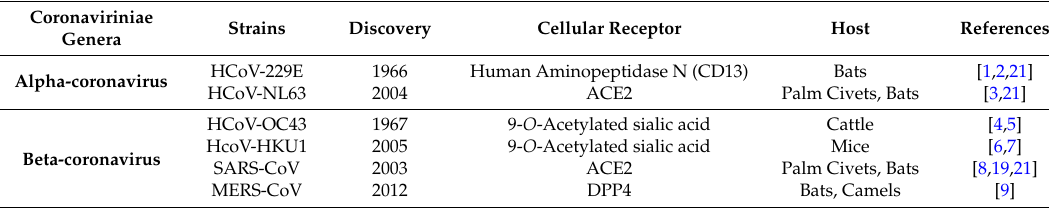
Table 1. Classification of human coronavirus.